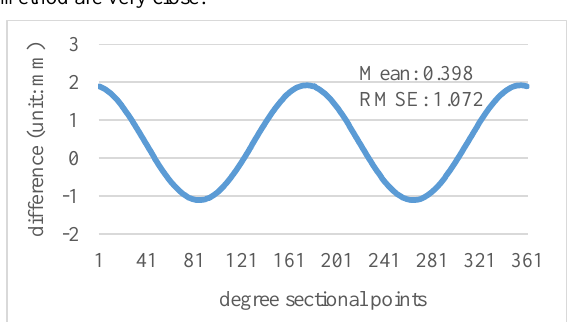
Figure 9 Differences of cross sectional lines 4.2.3 Result of denoising: It is not difficult to find from